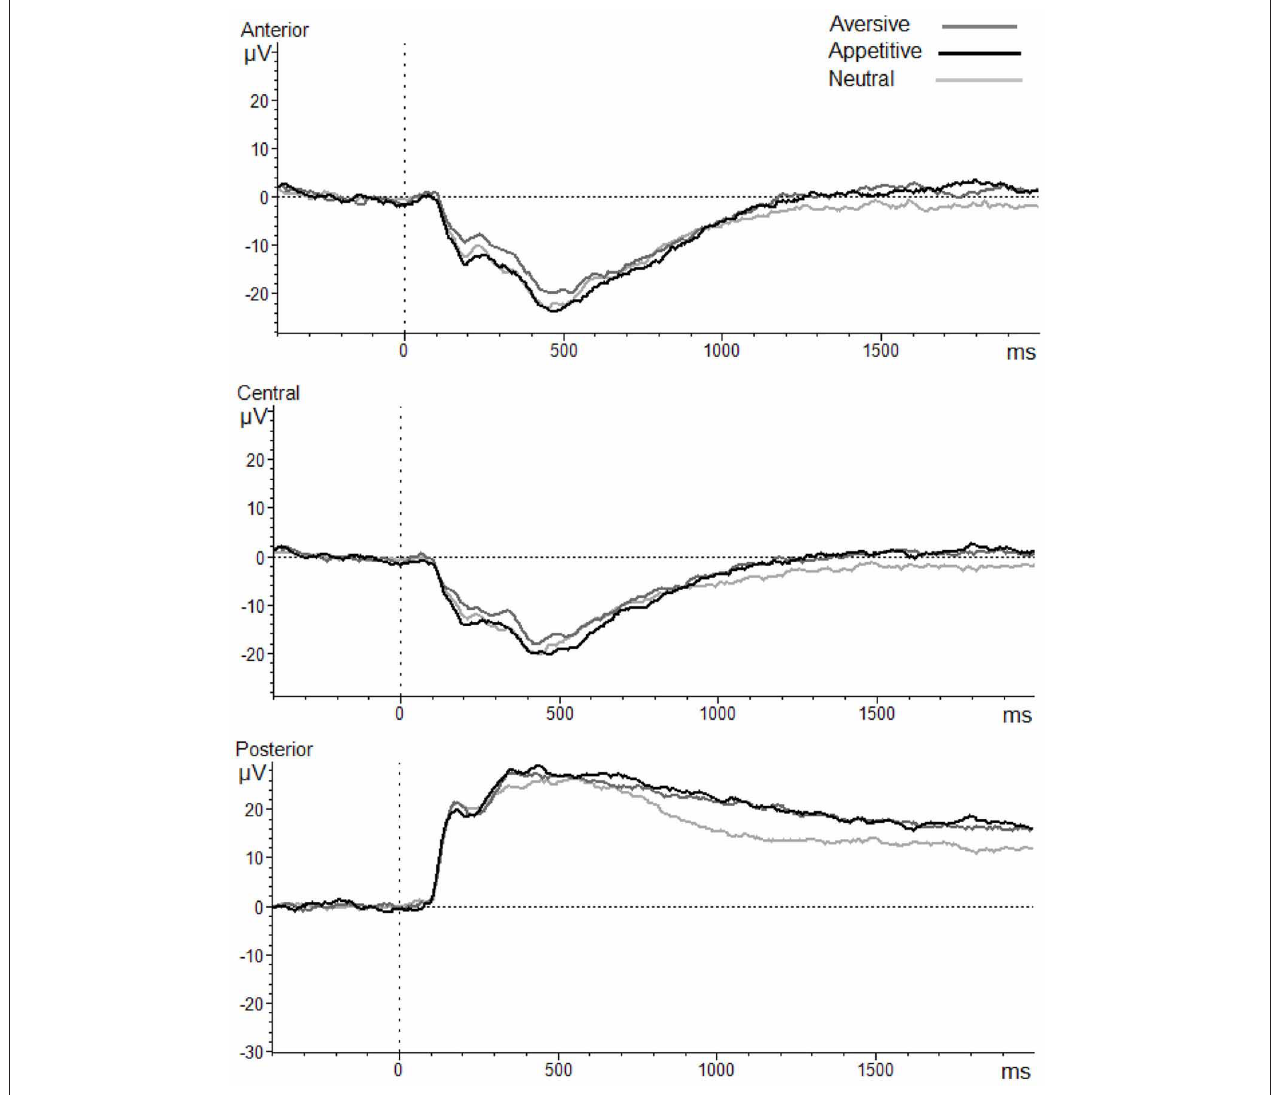
FIGURE 3 | LPP amplitudes in posterior, central and anterior regions during passively viewing aversive, appetitive, and neutral IAPS